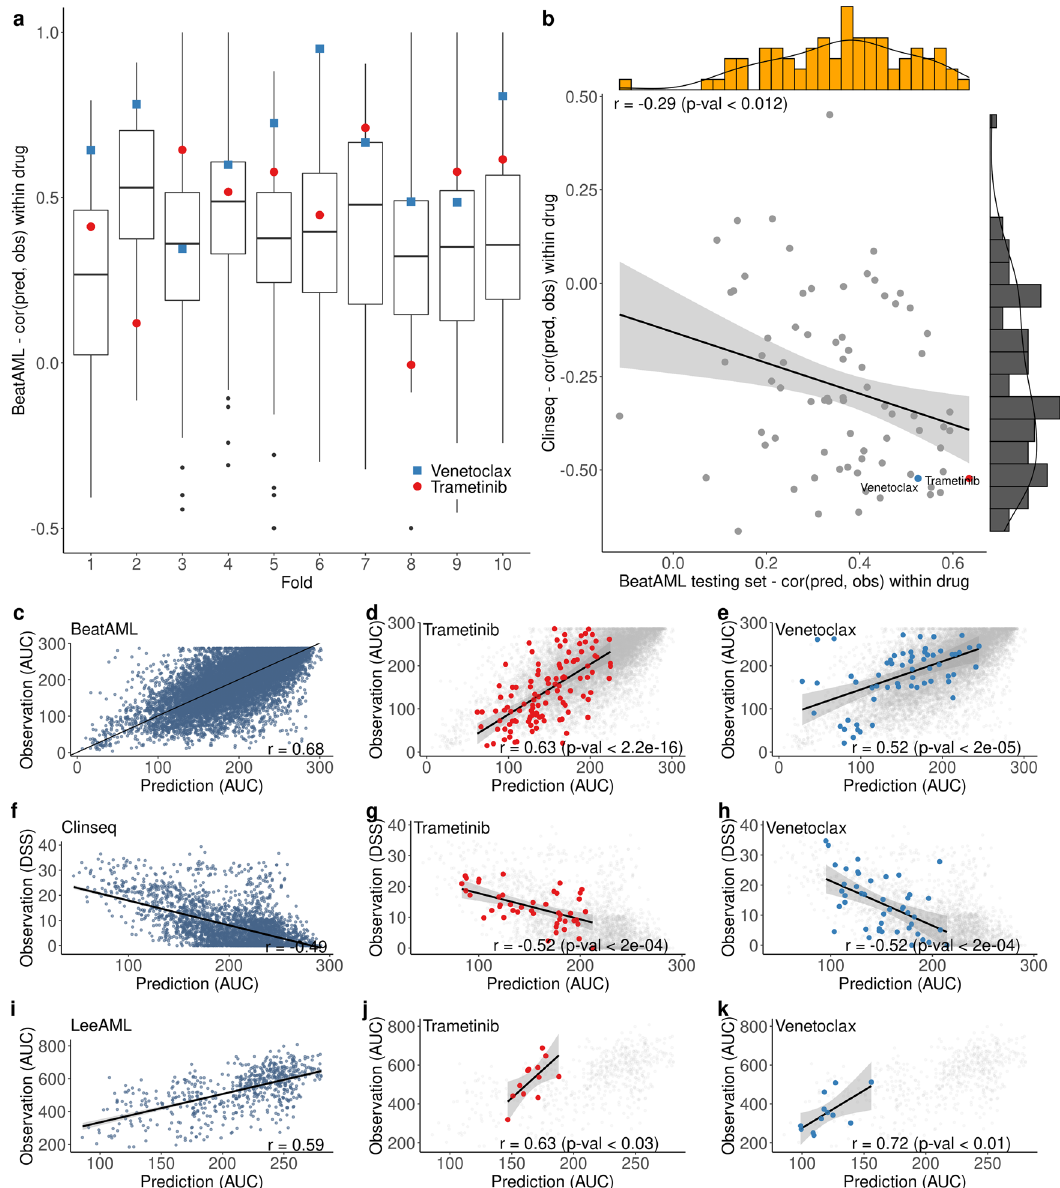
Fig. 2 Performance of MDREAM in BeatAML, Clinseq, and LeeAML. a Boxplots show the correlation of individual drugs from the tenfold cross-validation in the training set. Each boxplot displays the interquartile range (IQR) between the 25th percentile (the lower boundary) and the 75th percentile (the upper boundary). The center line of the box presents the median, and the whiskers are within the 1.5 IQR value. The points (blue or red) in each boxplot represent the correlation results of venetoclax and trametinib. b Prediction performances of the BeatAML testing set (x-axis) versus the Clinseq dataset (y-axis) across 76 overlapping drugs using the correlation between predicted values and observed values. The drugs at the bottom right indicate the drugs with good predictions in both cohorts. c – e Predicted AUCs vs observed AUCs of all data points ( c ) and individual drugs, including Trametinib ( d ) and Venetoclax ( e ) from the BeatAML testing set. f – k Similar scatter plots for predicted AUCs vs observed DSSs of the Clinseq dataset and LeeAML dataset, Supplementary Fig. 2. The correlations for all individual drugs are also shown in Supplementary Fig. 4. Trametinib and venetoclax, which have good performances in the BeatAML cohort, also archive top results in the LeeAML cohort, Fig. 2j, k. A negative correlation of some drugs in the LeeAML cohort might be due to the small number of samples ( n = 12).